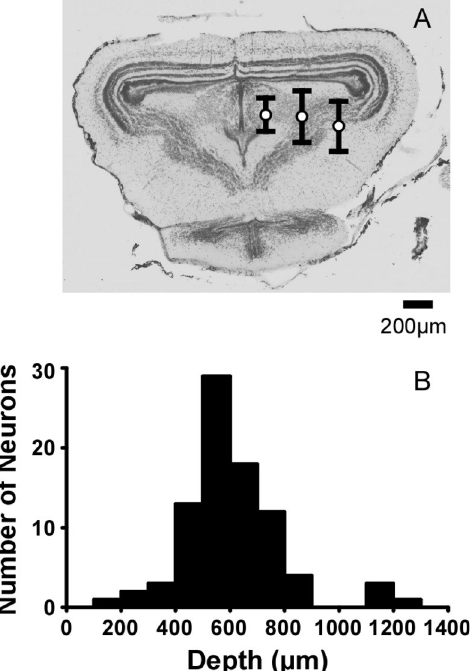
Fig 2. Distribution of recording positions. (A) Mean ( ± s.d.) depth for recorded cells. The electrode positions are categorized into three penetration columns: the medial, central, and lateral one thirds of the midbrain. The positions are plotted on a transverse section of the midbrain (upper schematic) stained with cresyl violet. (B) Histogram of depth for all whine sensitive cells, showing most recordings 500–700 μ m deep, bin width 100 μ